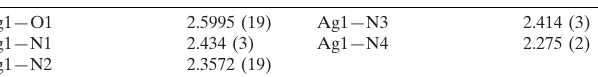
Selected bond lengths (A˚ ).